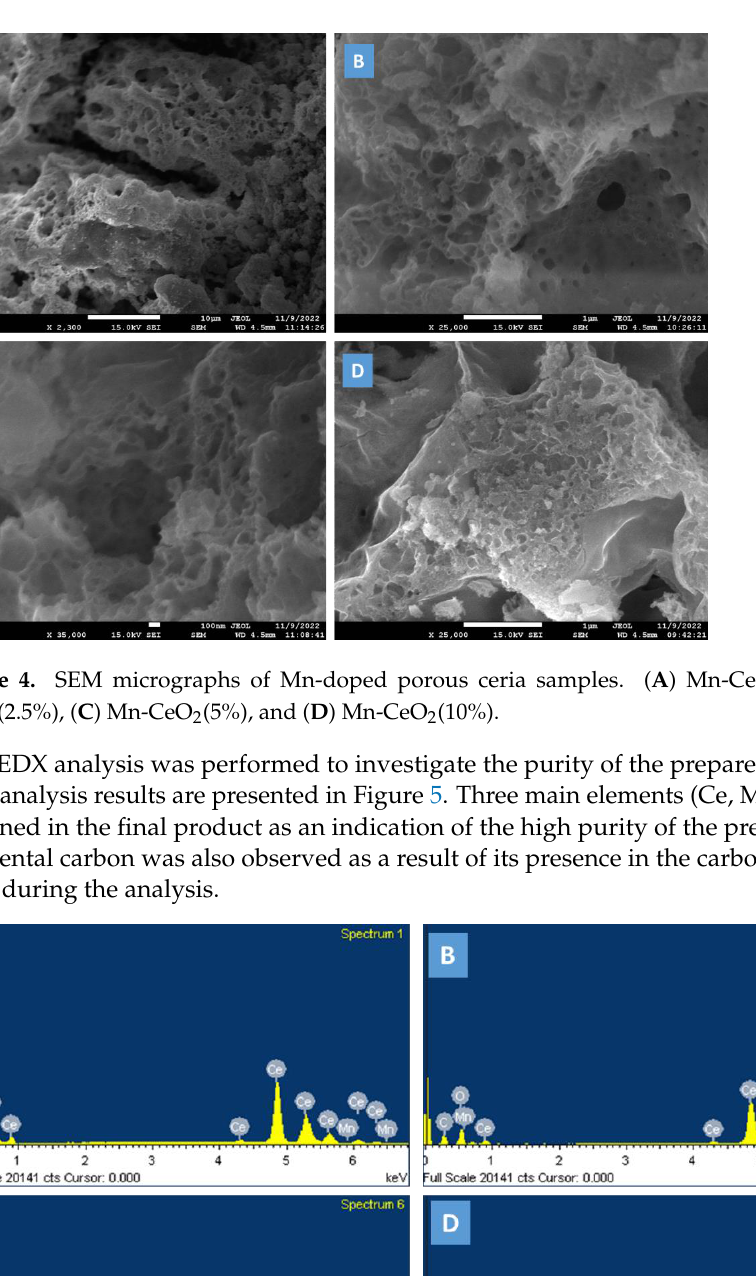
7 of 16 Figure 3. The bandgap calculation of Mn-doped porous ceria samples based on Kubelka – Munk function by using Tauc’s relation. The morphology of the prepared samples was investigated by SEM analysis. The ob- tained micrographs for the Mn-doped ceria samples are presented in Figure 4. From our previous study [35], it was observed that there is a huge difference between the morphol- ogy of commercial ceria and the porous ceria prepared by citric acid. The porous ceria sample has a rough surface with a sponge-like structure and there are obvious pores with